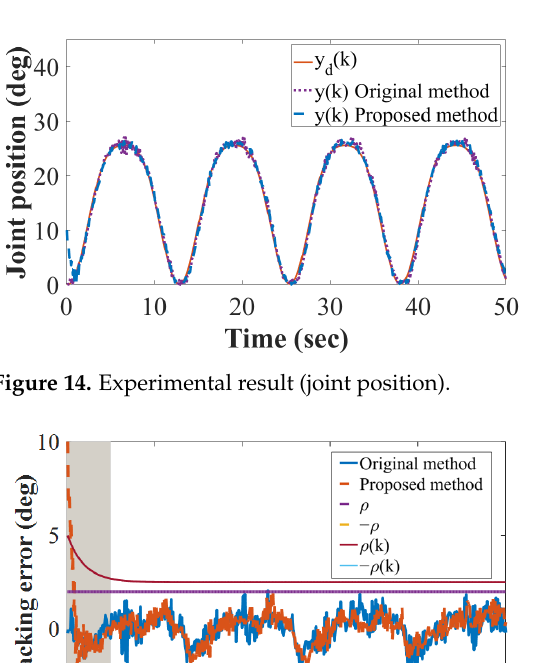
Figure 13. Passive robot-assisted rehabilitation.